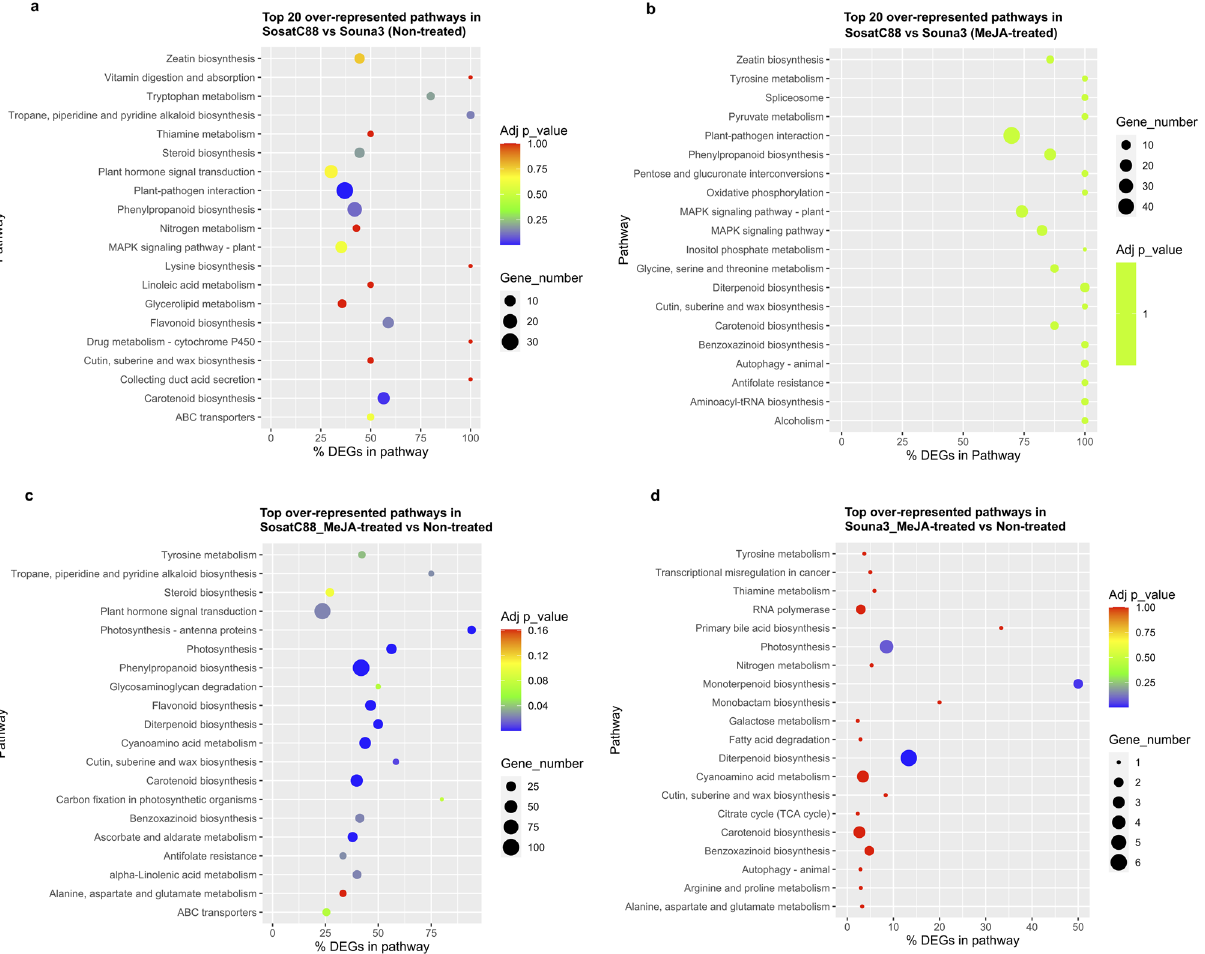
Figure 7. KEGG pathway enrichment analysis of the differentially expressed genes (DEGs) 72